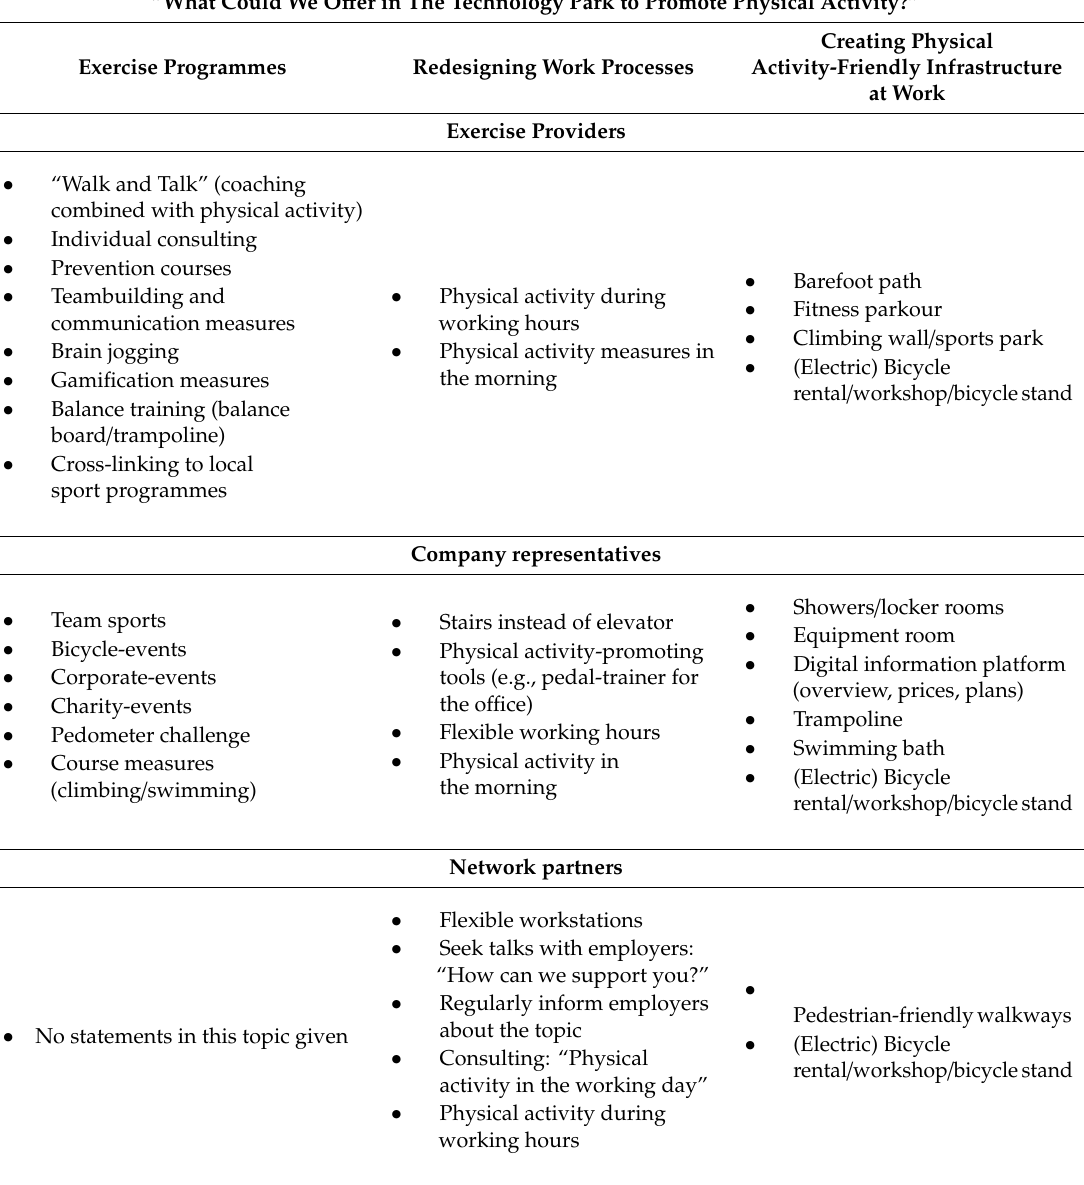
Table 3. Ideas of participating stakeholders for physical activity in the cross-company network